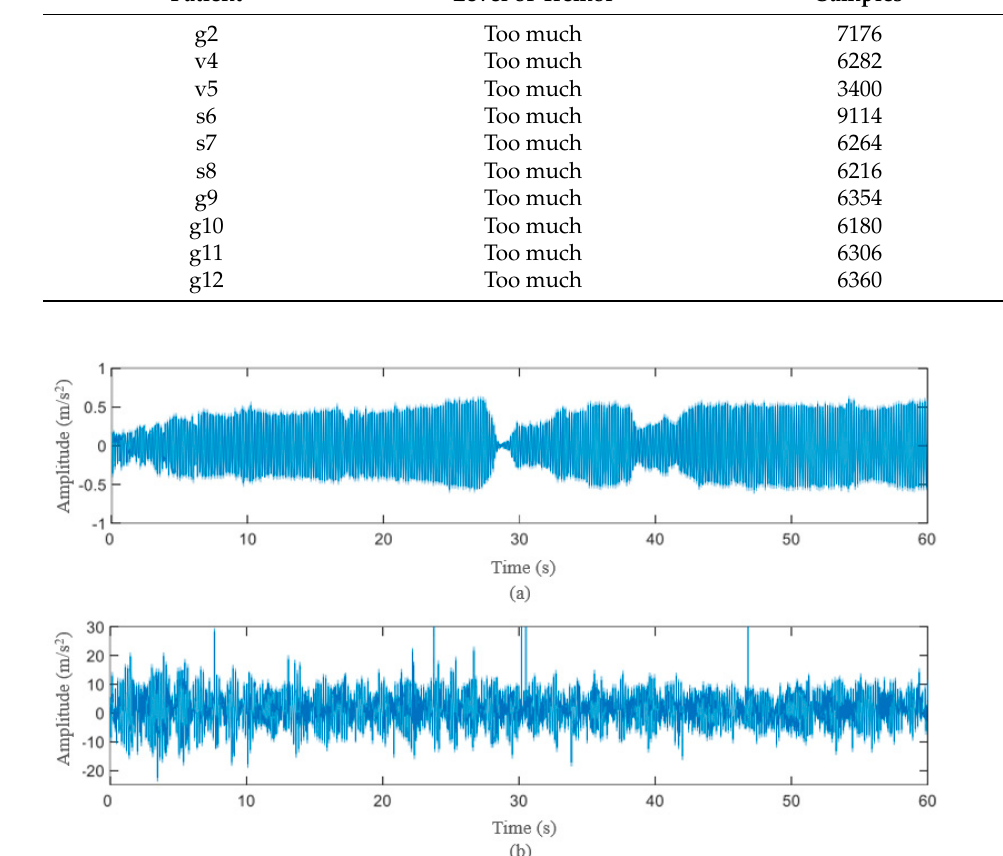
Figure 1. Analysis of the amplitude of tremor versus time from patients g2 ( a ) and g9 ( b ).